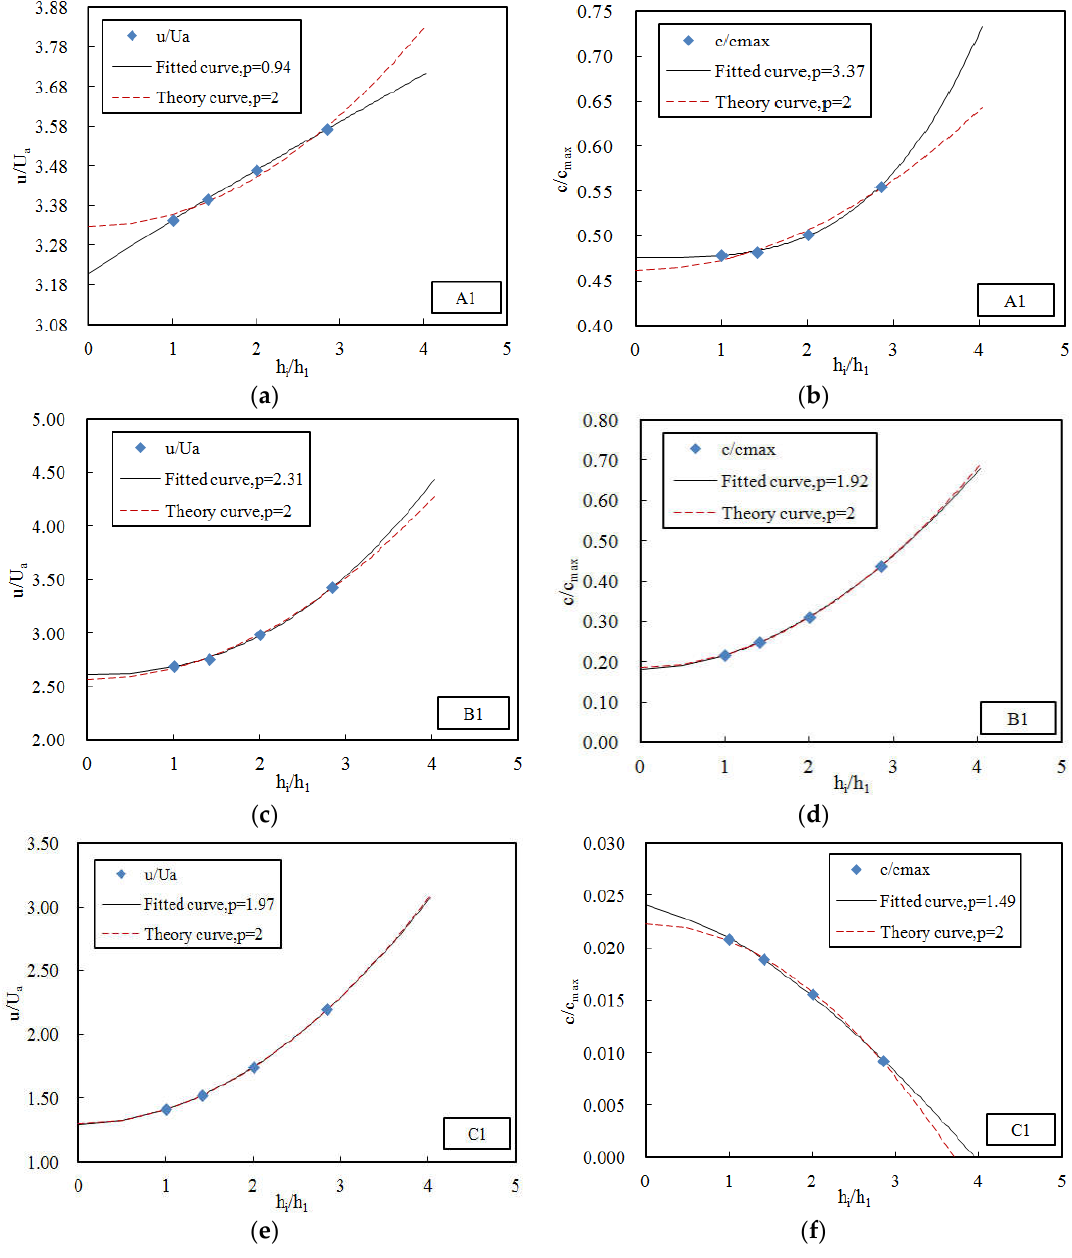
Figure 5. Grid convergence of the streamwise velocity and the concentration at different monitoring points: ( a , b ) A1, ( c , d ) B1, and ( e , f ) C1.